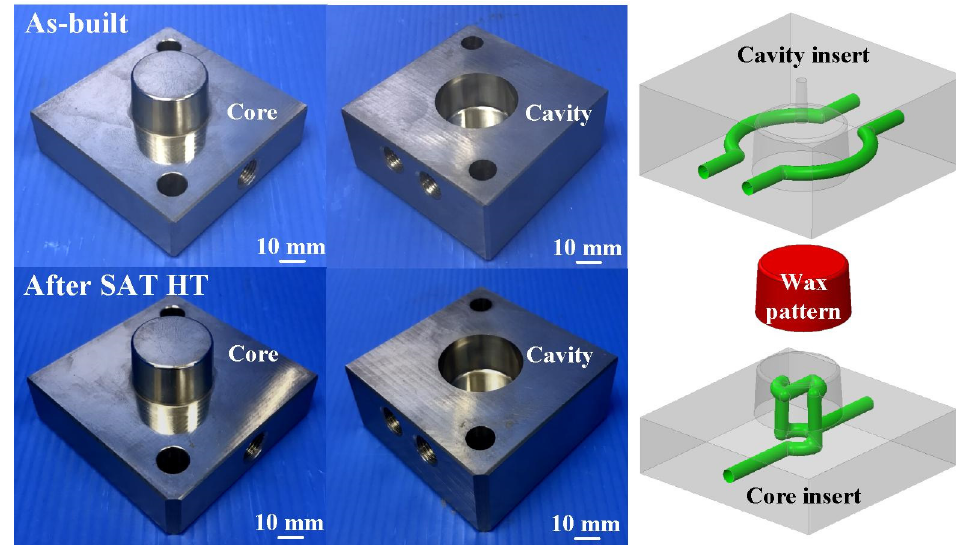
Figure 7. Two pairs of injection molds before and after SAT heat treatment.